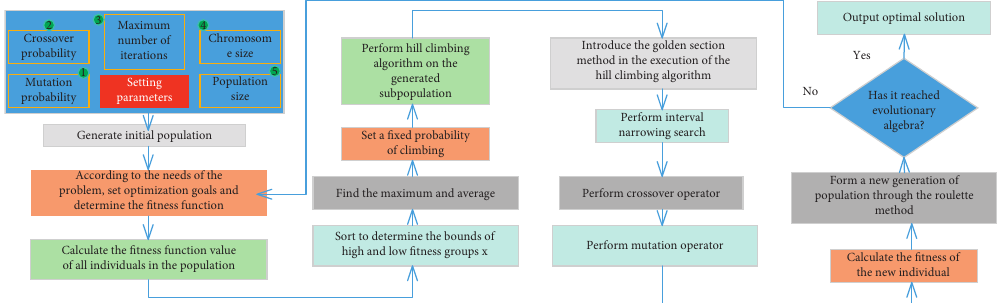
Figure 4: Improved algorithm